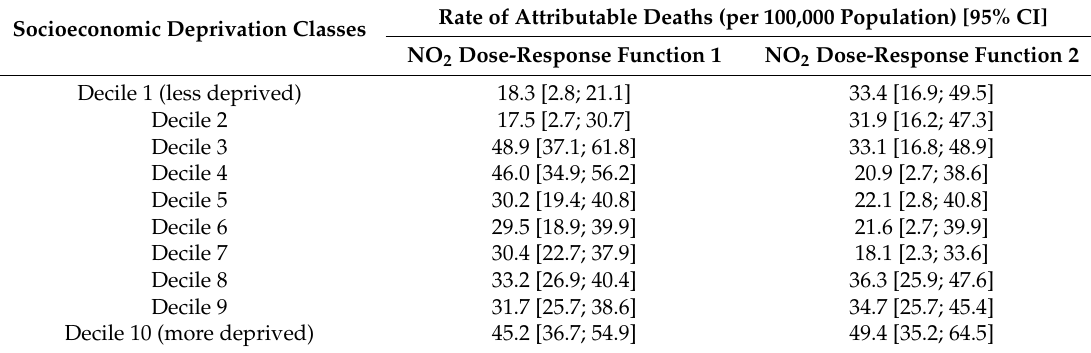
Table 5. Rate of attributable deaths per socioeconomic class for two dose-response function. Socioeconomic Deprivation Classes